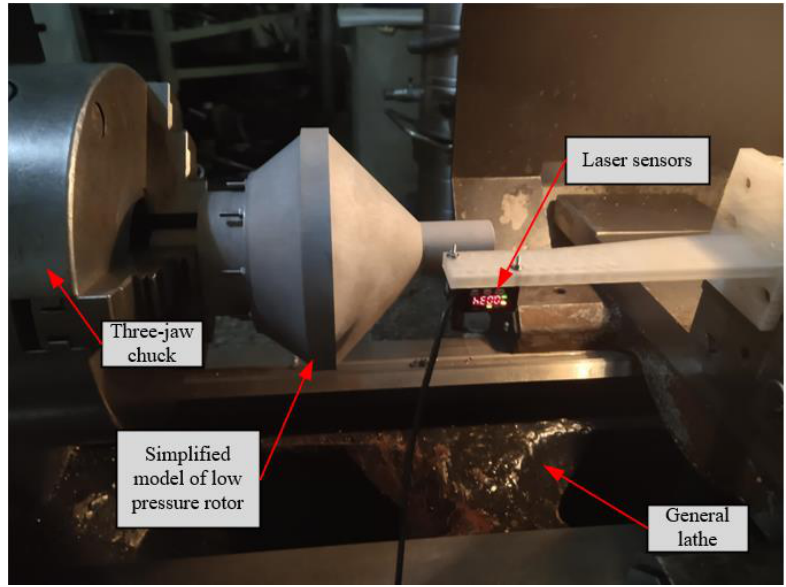
Figure 10. Experimental sample coaxiality measuring device.